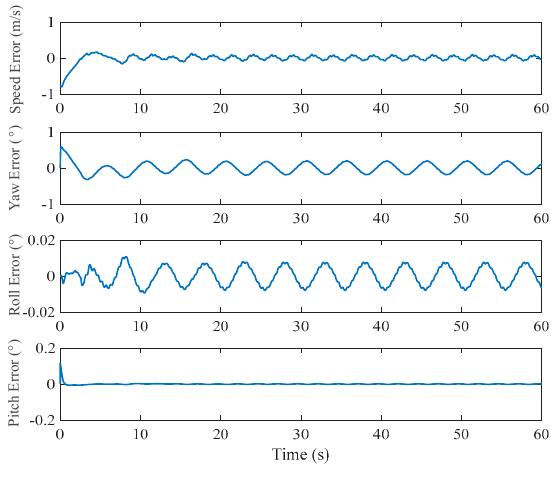
Figure 20. Errors for P 1 tracking. Figure 21. The robotic fish swings the flexible tail to keep the P 1 reference during closed loop tracking.